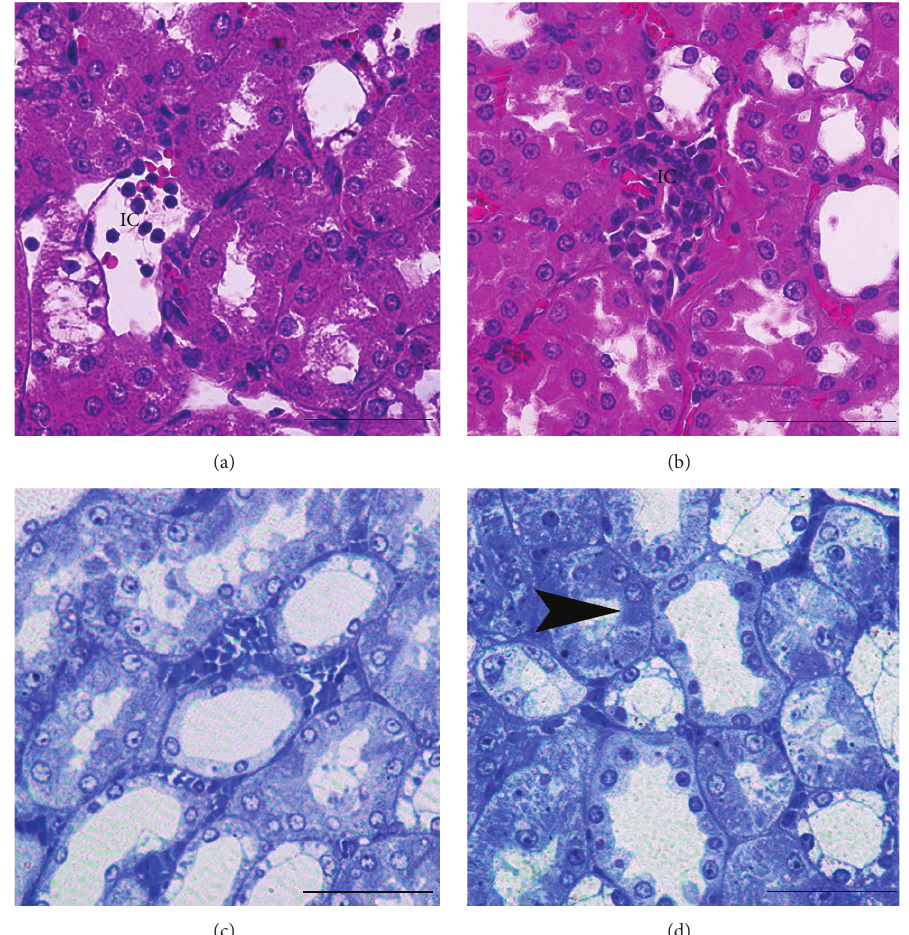
Figure 4: Morphology of renal tubular cells of MTDRs ((a), (c)) and MTCIN + DRs ((b), (d)). MTDRs showed similar patterns to HRs; however, inflammatory cell infiltration and vacuolization are demonstrated in MTDRs (arrow head). Histological section of the renal tissues contrast dye application after melatonin treatment (Figures 4(b) and 4(d)) showed mild interstitial leukocytes infiltration (Figure 4(b)) and Armanni-Ebstein lesions in tubule cells (arrow head) (Figure 4(d)). ((a) and (b)) Histological micrographs were stained with H&E and had scale bars with 150-micron size. Histological micrographs were stained with toluidine blue and had scale bars with 150-micron size (Figures 4(c) and 4(d)). MTDRs: melatonin-treated diabetic rats; MTCIN + DRs: melatonin-treated diabetic rats with contrast-induced nephropathy; HRs: healthy rats; CIN + DRs: diabetic rats with contrast-induced